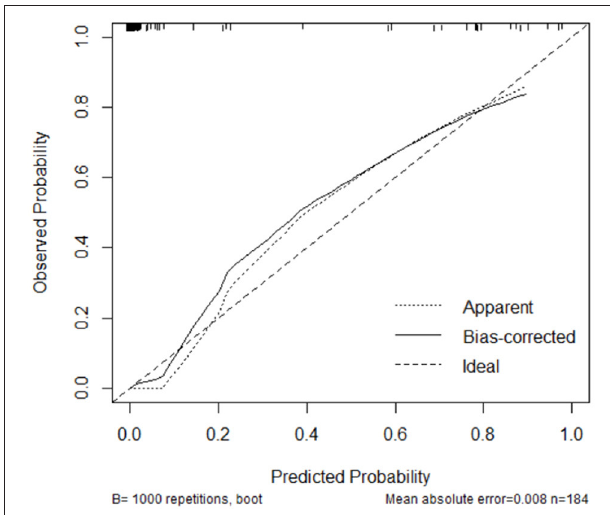
FIGURE 3 | Calibration of the